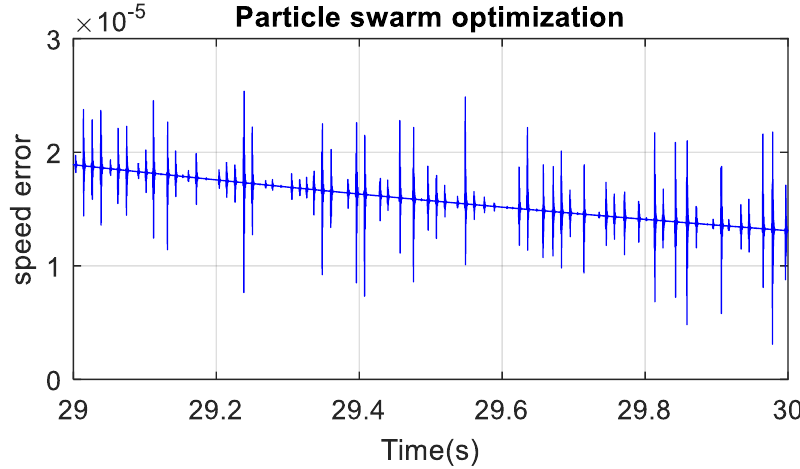
Figure 19. BEV absolute speed error with PSO.